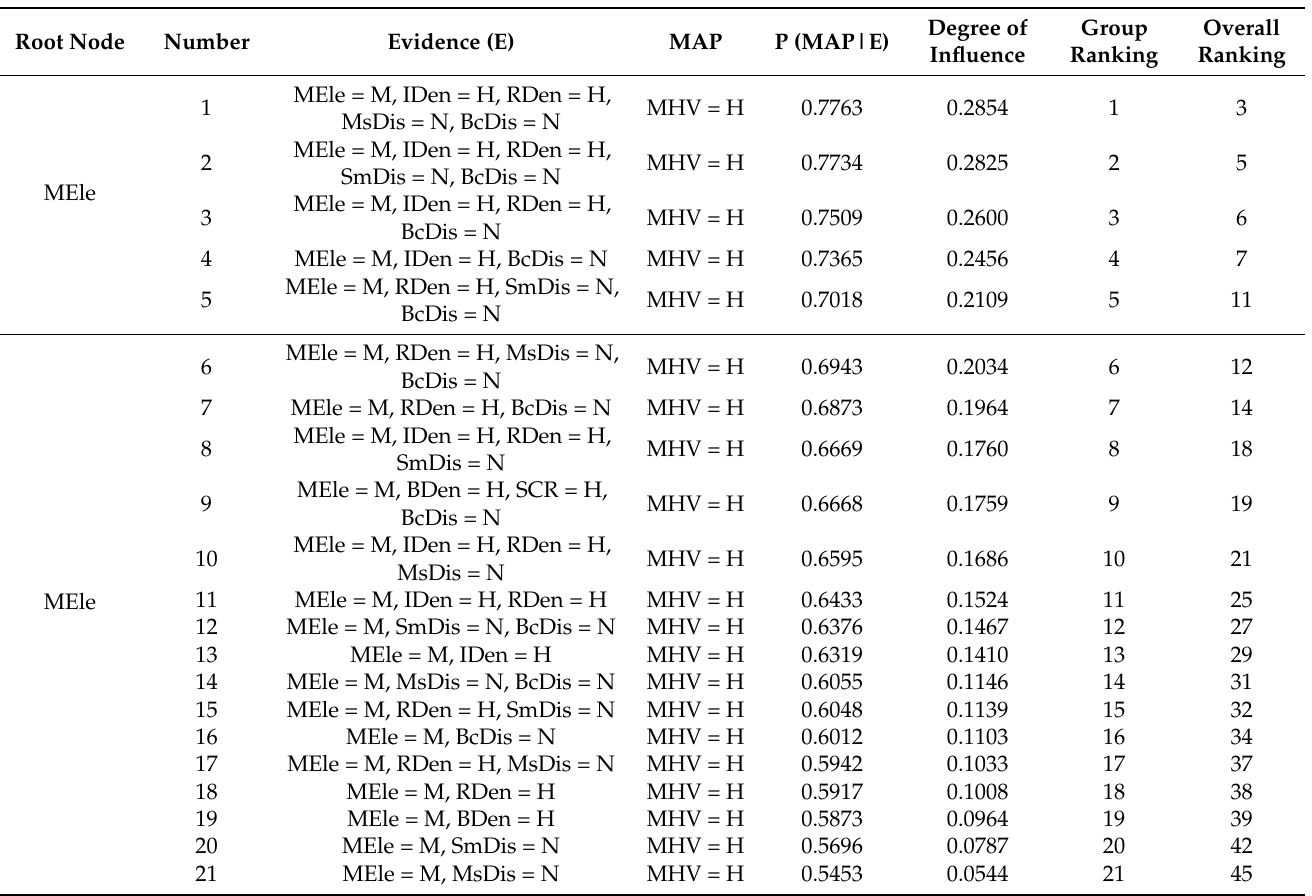
Table 8. Analysis of factor combination